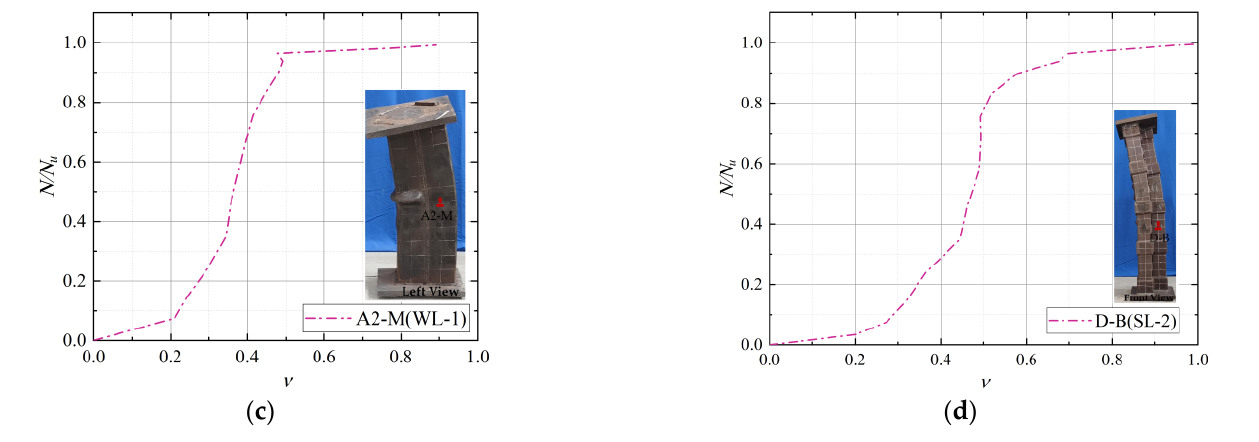
Figure 15. The process of stress changes in steel tubes and concrete.